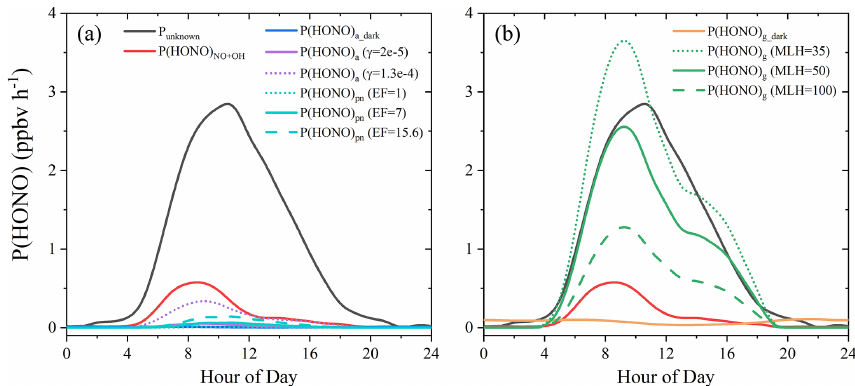
Figure 7. HONO production rates from different ( a : aerosol-derived, b : ground-derived) sources and unknown HONO source strength.